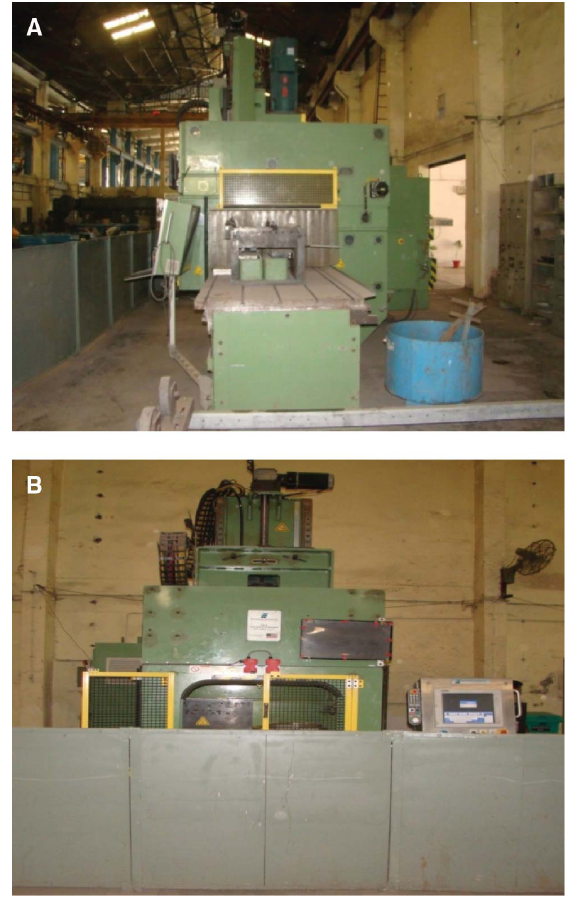
Figure 1: (A) Side view of the friction stir welding machine. (B) Front view of the friction stir welding machine.